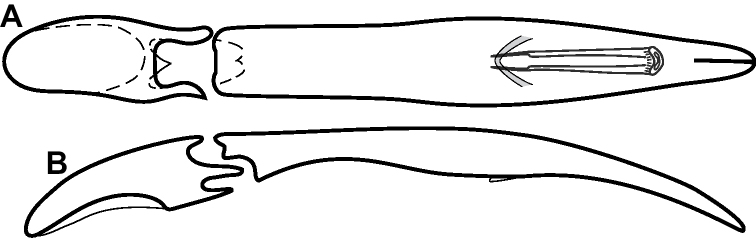
Male genitalia Phelister
blairoidesA aedeagus, dorsal B aedeagus, lateral.